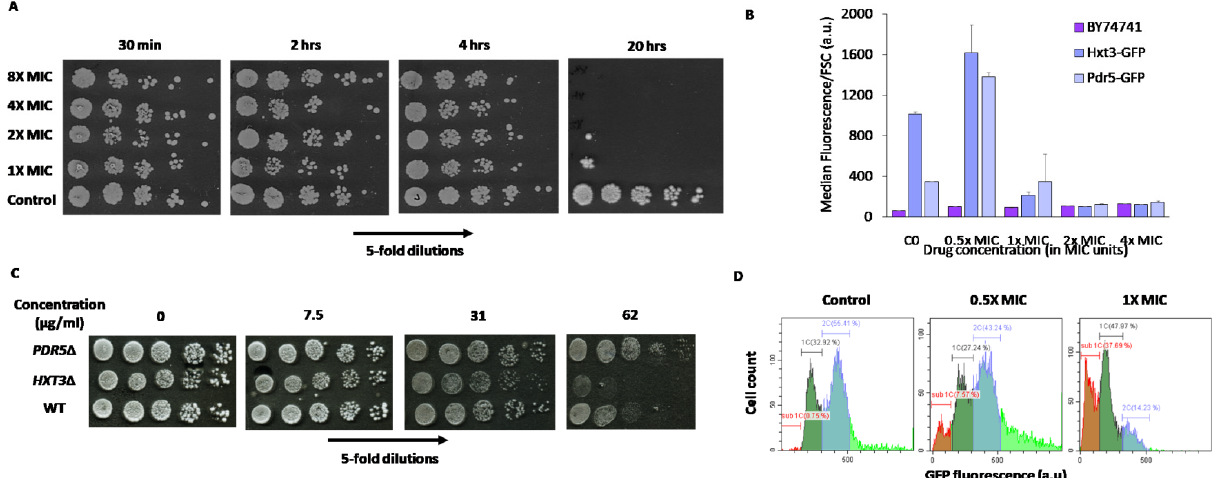
Figure 5. Effects of Mycosidine on cell growth and death and levels of several GFP-tagged proteins in S. cerevisiae yeast. ( A ) Spotting of BY4741 yeast treated with Mycosidine onto YPD shows that the drug efficiently kills yeast cells but only after a 24-h incubation; ( B ) Flow-cytometric analysis of GFP-fusion protein fluorescence in yeast cells shows that Pdr5 and Hxt3 are induced after 0.5 × MIC (7.8 mg/L) treatment of S. cerevisiae cells by Mycosidine. Presented data are median fluorescence values for living cells (negative for PI staining); ( C ) Yeast strains (BY4742) with deletions of the noted genes were spotted onto YPD plates containing the noted concentrations of Mycosidine. Deletion of the Pdr5 gene did not cause increased sensitivity to Mycosidine, whereas deletion of HXT3 did; ( D ) Distributions of Htb2 ‐ GFP fluorescence in live cells treated with different concentrations of Myco ‐ sidine. Sub1C (orange), 1C (green), and 2C (grey) denote the putative amount of DNA in the cells. The percentage of cells in each population is noted.